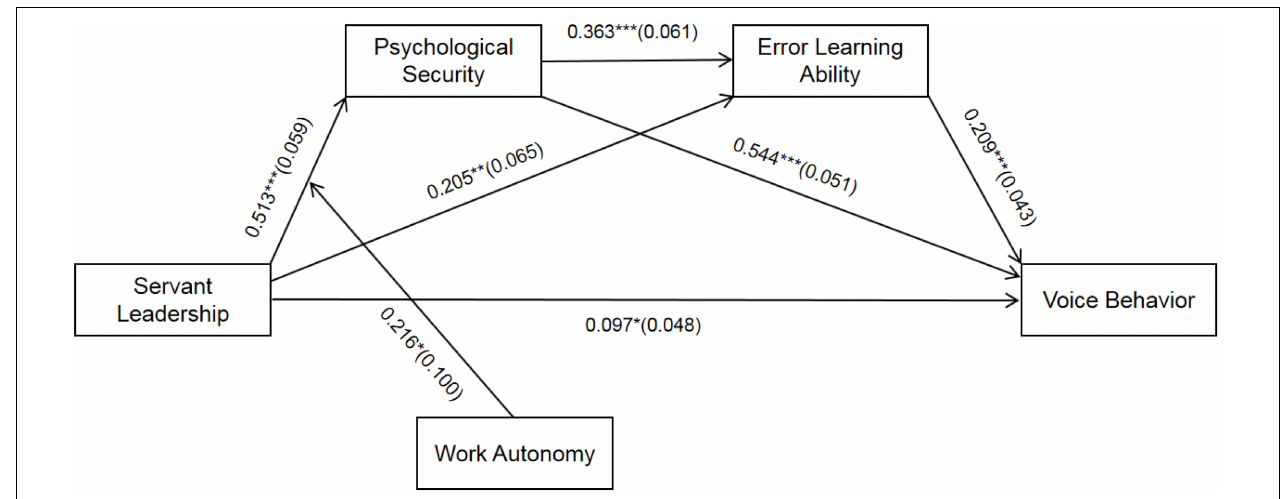
FIGURE 2 | Path coefficient of structural equation. ***, **, *stand for P < 0.001, P < 0.01, P < 0.05, respectively, the coefficient in the figure is the standardization coefficient, and the standard errors are in brackets. The control variables are age, gender, and education level.